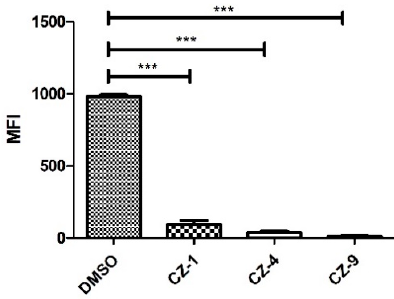
Figure 6. Promoter activities of hrcT in Xoo grown in XOM2 supplement with 200 µ M of CZ-1, CZ-4, and CZ-9 for 15 h, measured by fluorescence-activated cell sorting (FACS). At least three independent tests were performed with similar results. Asterisks indicate statistically significant differences (Student’s t -test) *** p < 0.01.